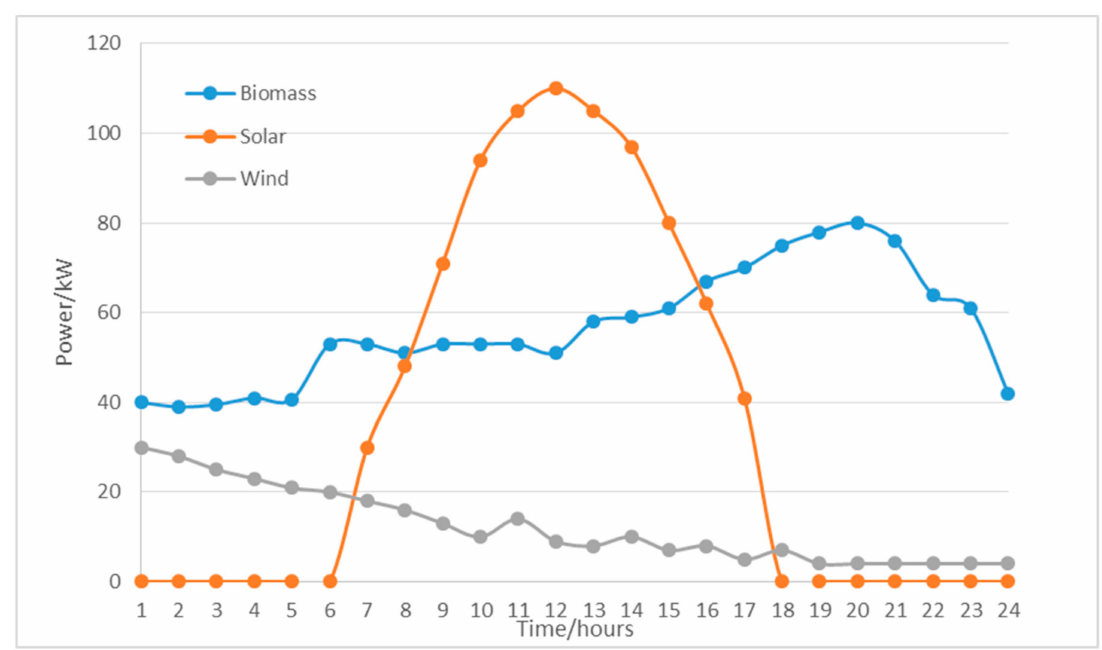
Figure 8. Example of renewable energy power generation patterns